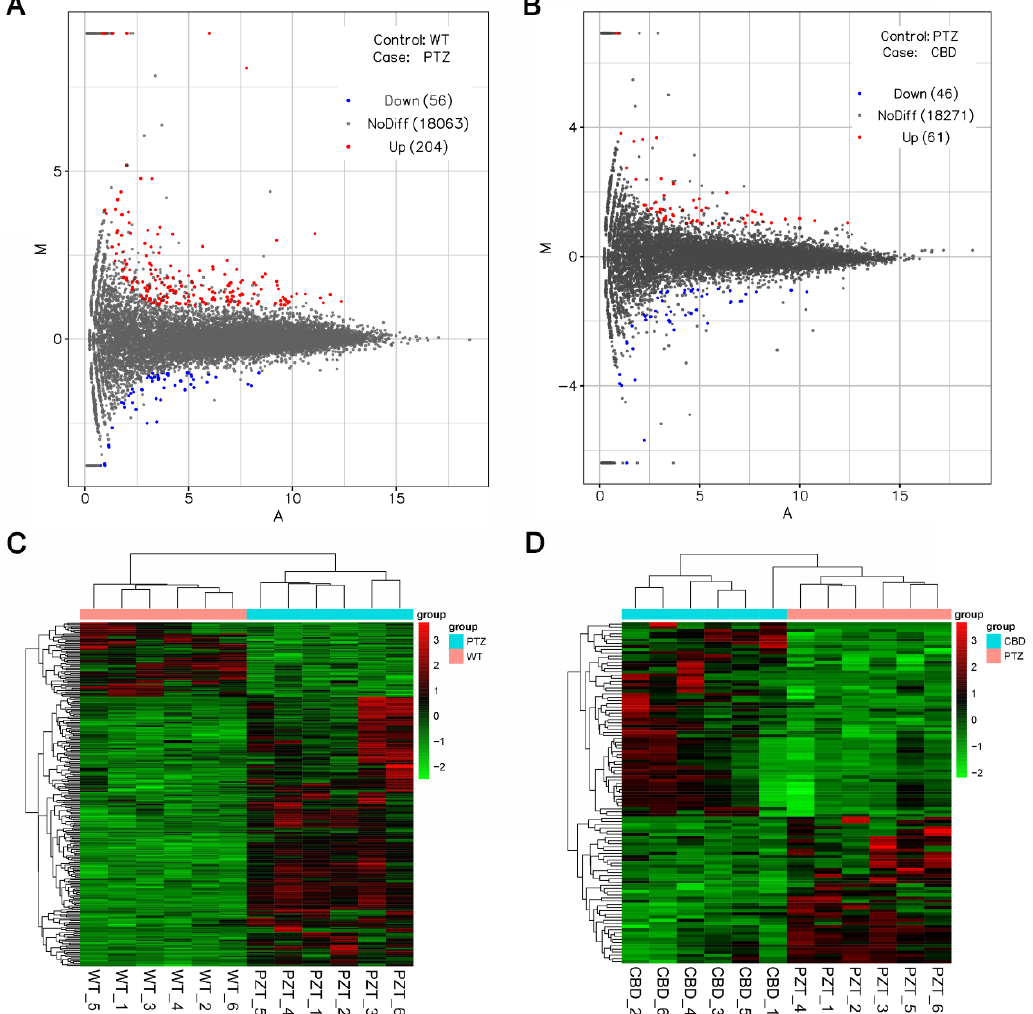
Figure 3. Gene expression profiling analysis of PTZ and CBD vs. PTZ. ( A ) The relationship between the different genes in each group. ( B ) The number of up - regulated and down - regulated DEGs between the groups. ( C , D ) The cluster analysis between different groups, n = 6 per group.